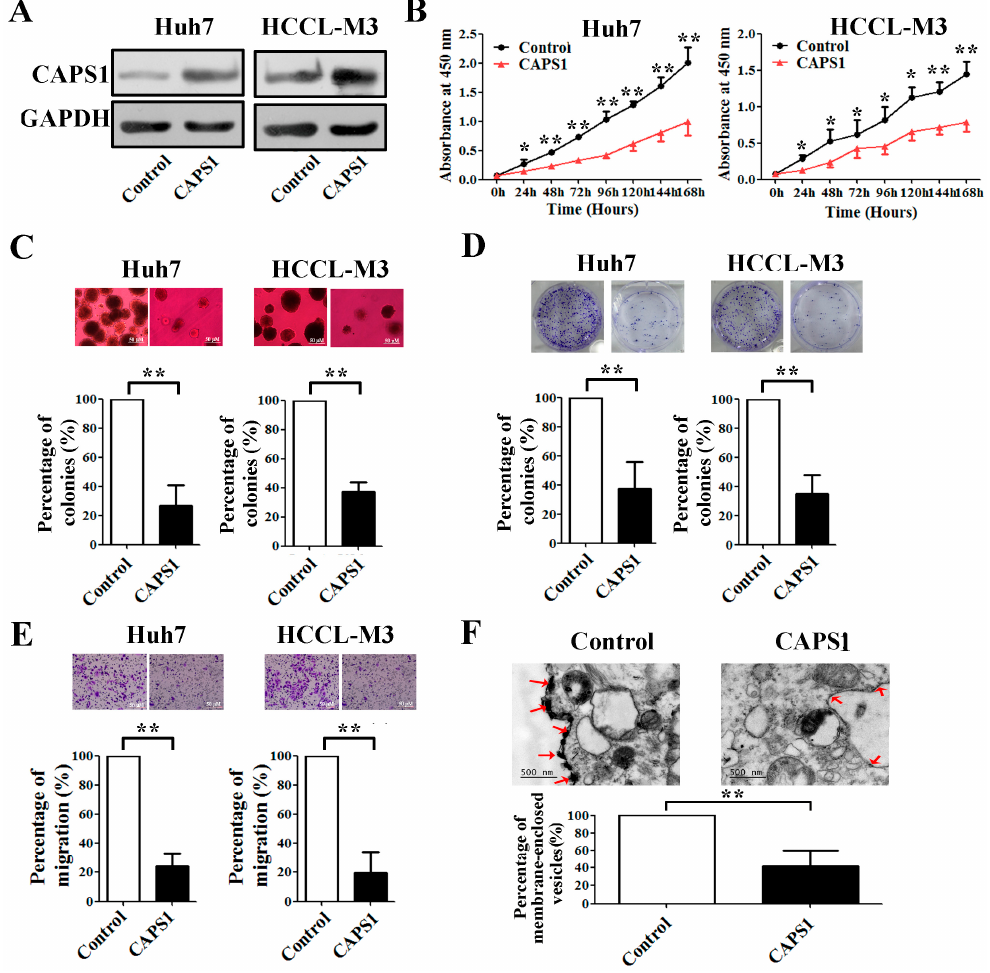
Figure 3. CAPS1 overexpression reduced cell proliferation and migration and inhibited exocytosis in HCC cells. ( A ) CAPS1 overexpression efficiency was verified by Western blotting in Huh7 and HCCLM3 cells; ( B ) Cell growth curves of Huh7 and HCCLM3 cells transfected with control vector or CAPS1; ( C – E ) Soft agar colony assay ( C ), Plate colony formation assay ( D ) and transwell migration assay ( E ) for Huh7 and HCCLM3 cells transfected with control vector or CAPS1; ( F ) Representative electron microscopy images of Huh7 cells transfected with control vector or CAPS1. Arrow points: membrane-enclosed vesicles. Representative pictures are shown in top panels. Quantitative results of at least three independent replicates are shown in bottom panels. * p < 0.05; ** p < 0.01.